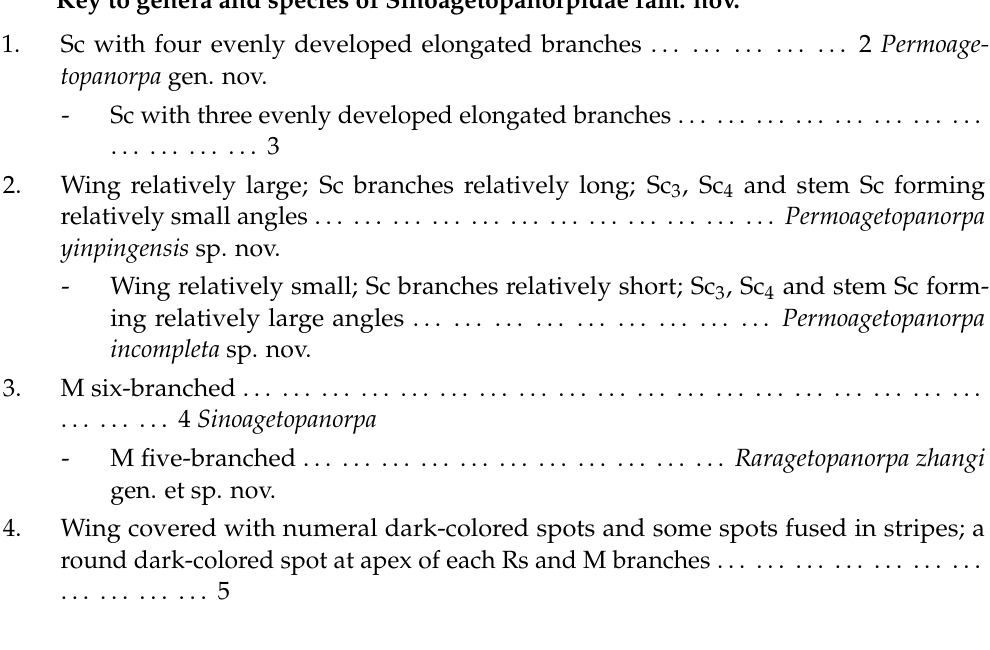
Figure 18. Line drawings of hind wings of Sinoagetopanorpidae fam. nov. ( A ) NIGP200930; ( B ) NIGP200932; ( C ) NIGP200934 (mirror image); ( D ) NIGP200933; ( E ) NIGP200931; ( F ) NIGP200935; ( B – F ) with dark color unillustrated. Scale bar represents 1 mm.